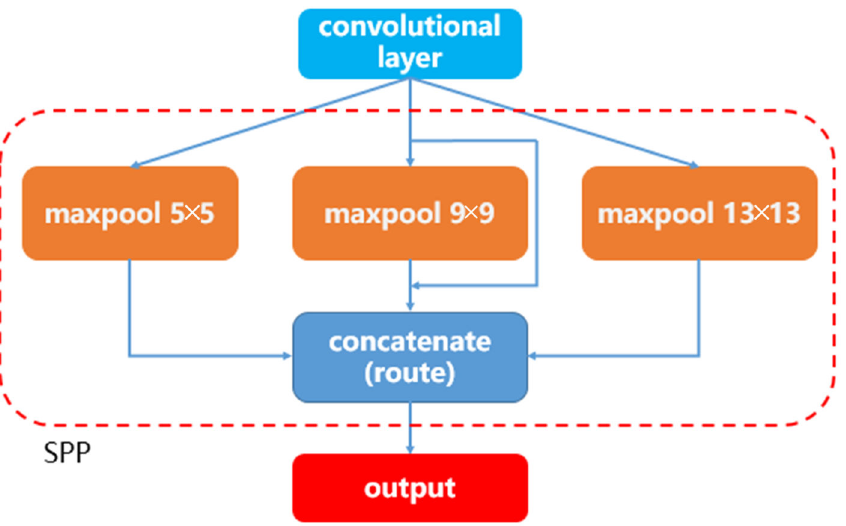
Figure 4. The architecture of the SPP module. The “maxpool” represents the max pooling layer. “concatenate” represents the concatenation layer, which can concatenate two inputs at the channel dimension.